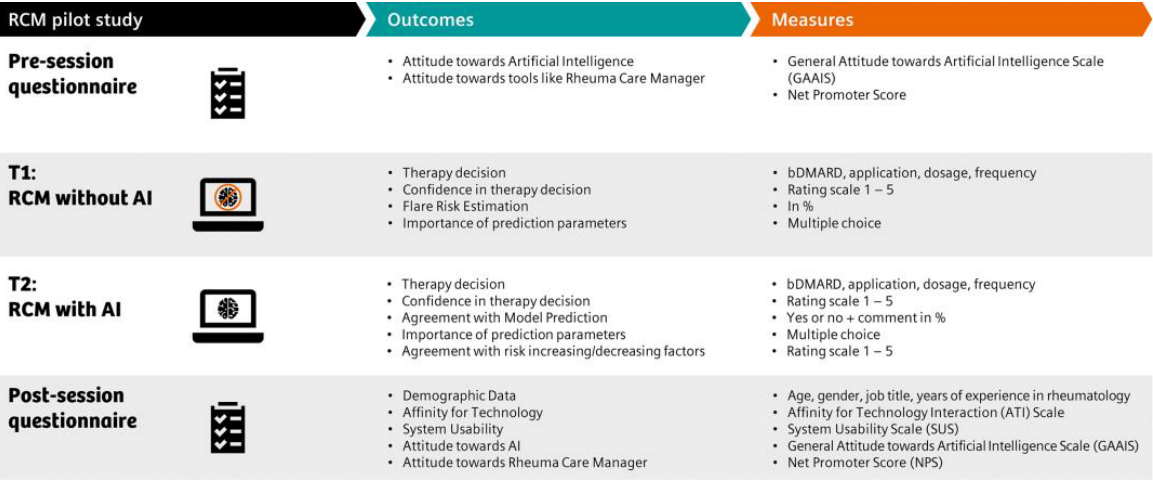
Figure 2. Outcomes and measures of the pilot study. The outcomes (2nd column, petrol) and measures (3rd column, orange) of part 2 are listed in table form and assigned individual study sections (1st column, black) line by line.